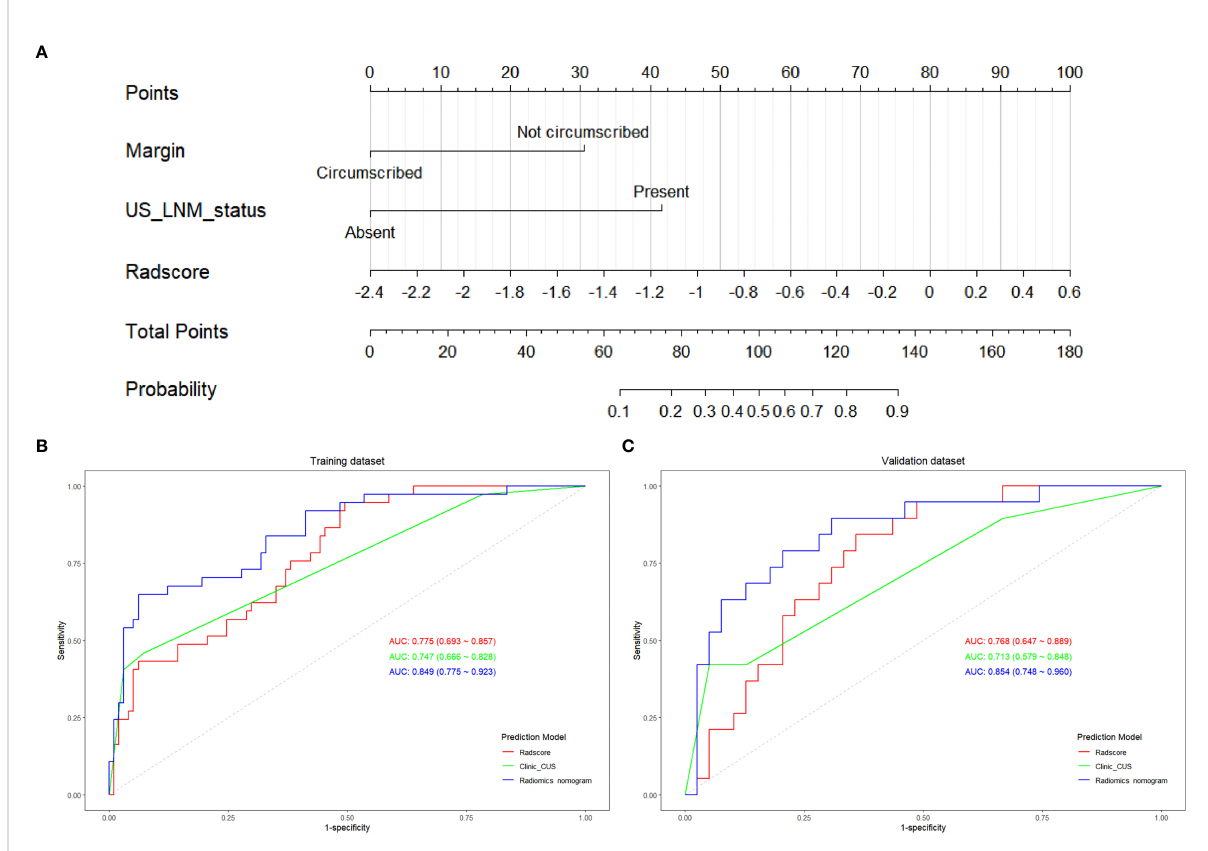
FIGURE 5 The construction of radiomics nomogram and the ROC curves of Radscore, clinic_CUS, and radiomics nomogram models. (A) Radiomics nomogram model visualized and constructed with tumor margin, US_LNM status and Radscore. The ROC curves of the Radscore model, clinic_CUS model, and radiomics nomogram model in training (B) and validation (C)